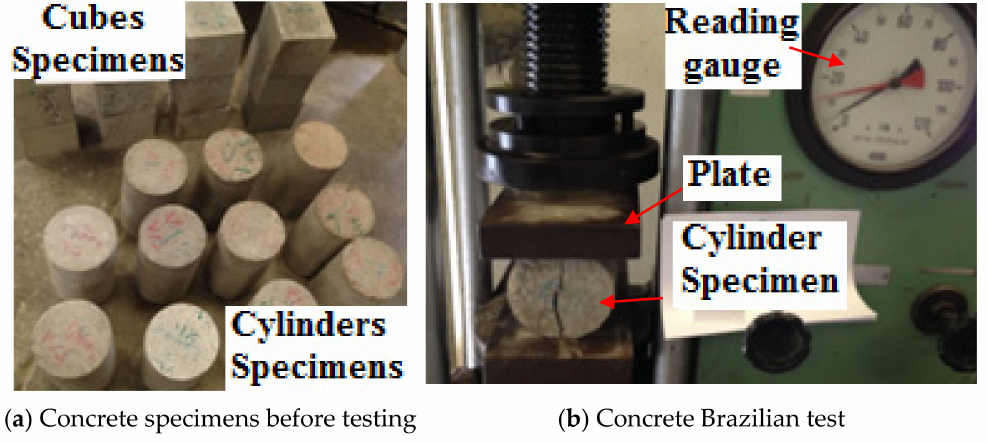
Figure 3. Cylinder specimen after curing and testing: ( a ) concrete specimens before